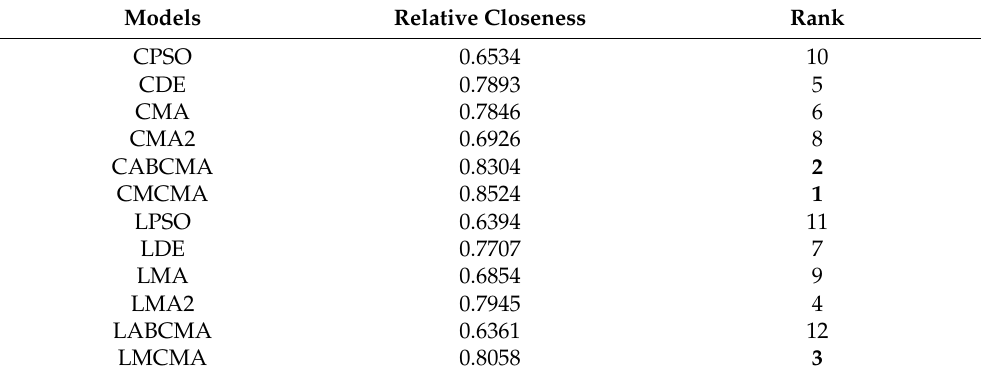
Table 8. Ranking for BTC/JPY